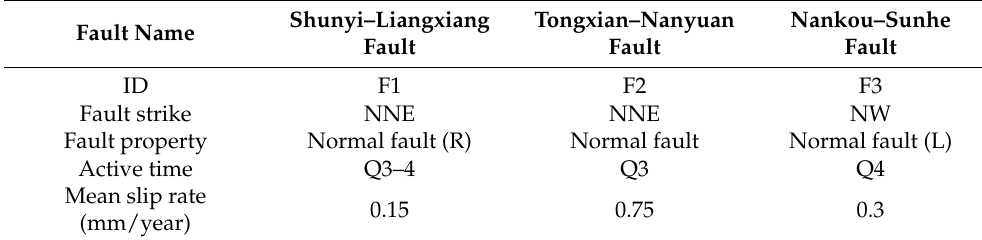
Figure 1. Geographical location of the study area. ( a ) Sentinel-1 SAR image coverage. ( b ) Sketched map of the study area. F1: Shunyi–Liangxiang fault. F2: Nanyuan–Tongxian fault. F3:Nankou–Sunhe fault. Table 1. Characteristics of the main faults in the eastern Beijing Plain based on Xu et al. [53]. Q2, Q3 and Q4 indicate the middle Pleistocene, late Pleistocene and Holocene, respectively. R: right-lateral, L: left-lateral. See Figure 1 for a map of the fault locations.